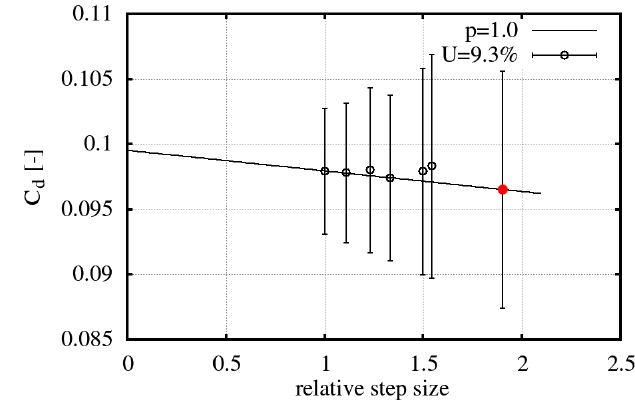
Figure 23. Convergence of the